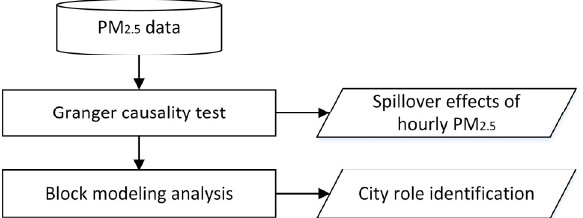
Figure 2. Analysis framework of intercity OVERFLOW effect of PM 2.5